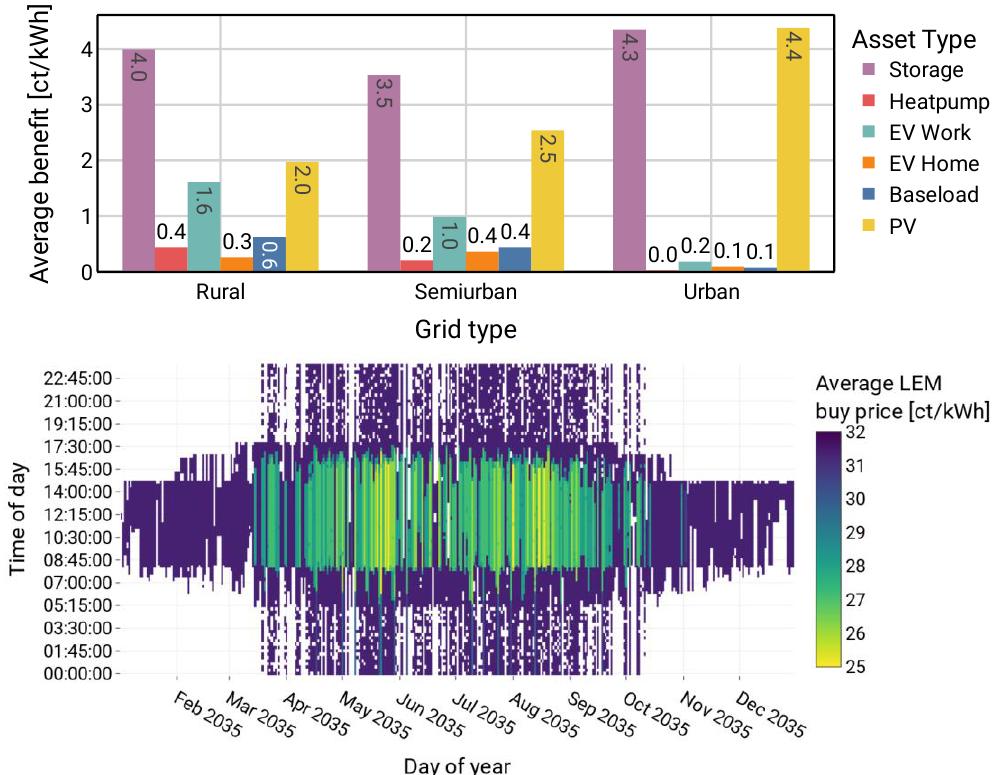
Figure 10. Heatmap of weighted average buy prices (gross) for scenario year 2035, the rural grid and the scenario with flat participant fees.